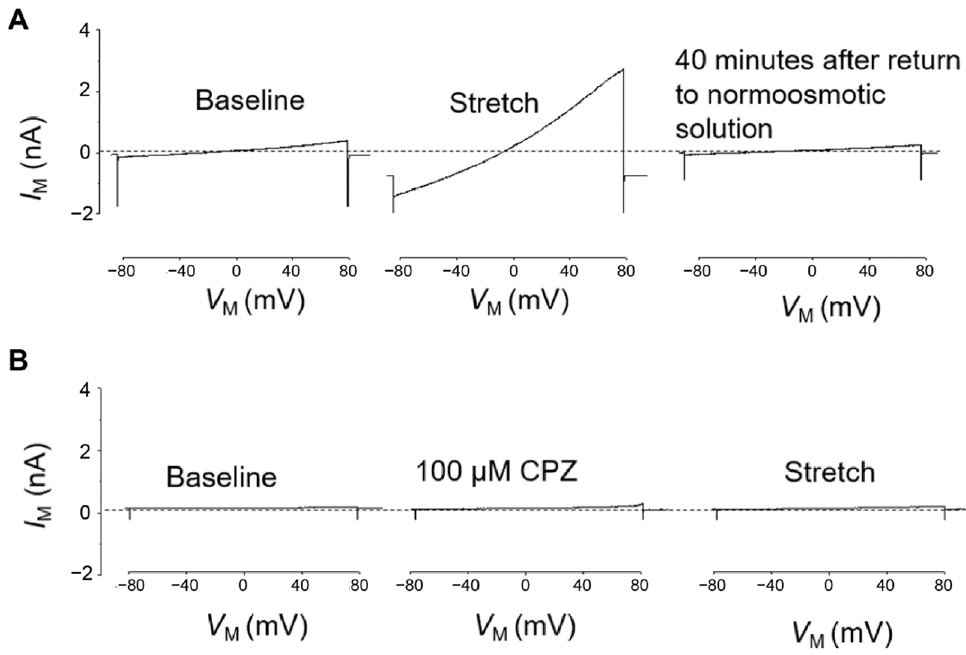
Figure 3. Hypotonic stretch-induced TRPC6 currents are largely enhanced in PON2 deficiency and reduced after capsazepine treatment. Representative whole cell voltage clamp recordings of PON2-deficient podocytes after treatment with 1% DMSO ( A ) or capsazepine ( B ). ( A ) In DMSO-treated PON2-deficient podocytes perfusion with a 70% hypotonic solution induced a marked increase in cationic currents recorded during application of ramp voltage commands (from − 80 to +80 mV). These currents remained elevated for ~40 min after the cells were returned to a normotonic extracellular solution. ( B ) In a different PON2-deficient podocyte, exposure to 100 µM capsazepine in a normotonic solution caused a slight increase in currents recorded during the application of ramp voltage commands. No additional increase in currents was observed when cells were subsequently exposed to a hypotonic stretch solution.